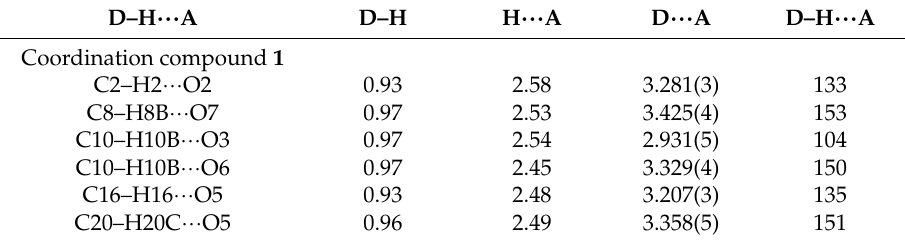
Table 3. Hydrogen bonding interactions (Å, ◦ ) of coordination compound 1 .